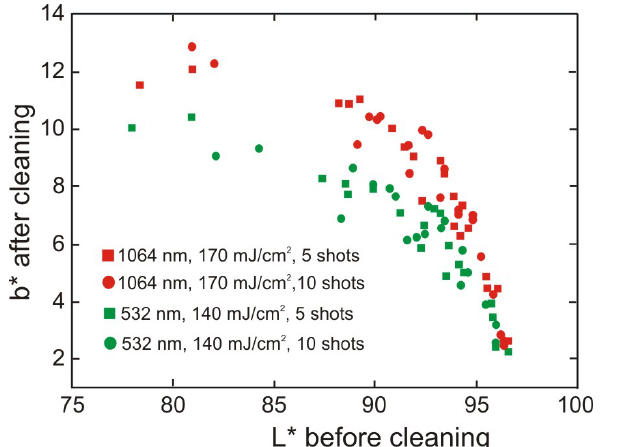
Figure 39. Yellowing of the substrate after laser cleaning as a function of density of the deposited soiling. Higher b * denotes more yellow component, lower L * denotes higher soiling density. Pulse repetition rate of 10 s -1 .